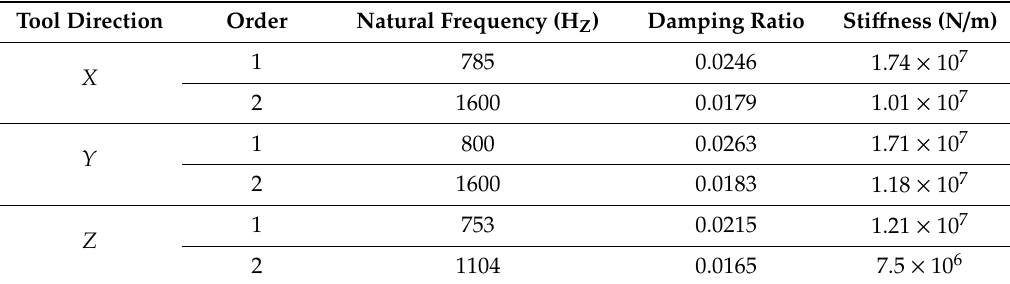
Table 4. Modal parameter table of the milling